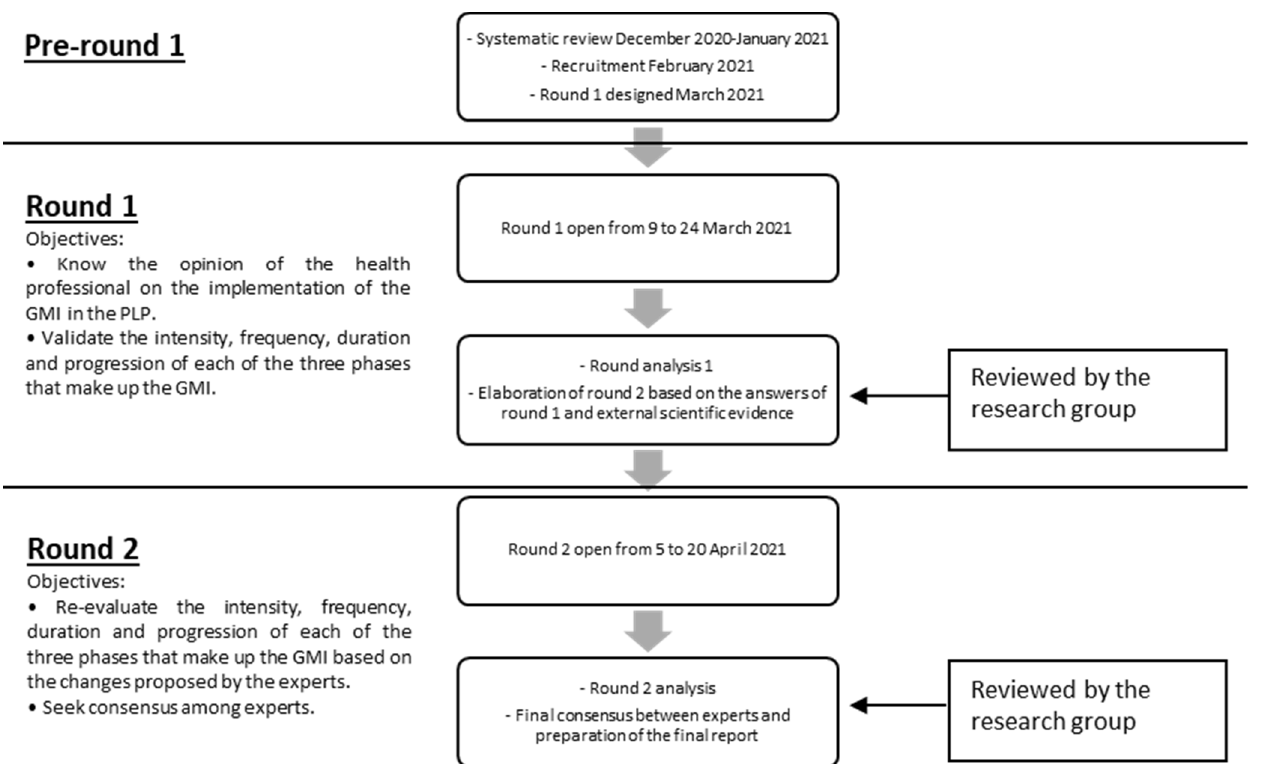
Figure 1. Study flow and objectives.